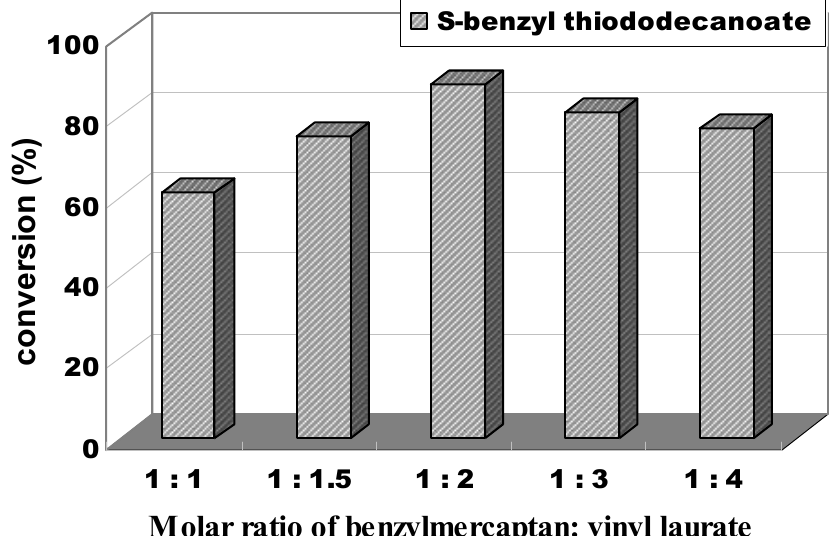
Figure 2. The influence of substrate molar ratio (benzyl mercaptan:vinyl laurate) on the enzymatic synthesis of thioesters in a continuous flow microreactor: 10.4 µL min −1 feed 1 (4 mmol thiol derivatives in 10 mL DMSO) and 10.4 µL min −1 feed 2 (4–16 mmol vinyl esters in 10 mL DMSO) at 50 °C (residence time 30 min), Lipozyme TL IM (0.87 g, 44 mg mL −1 ).